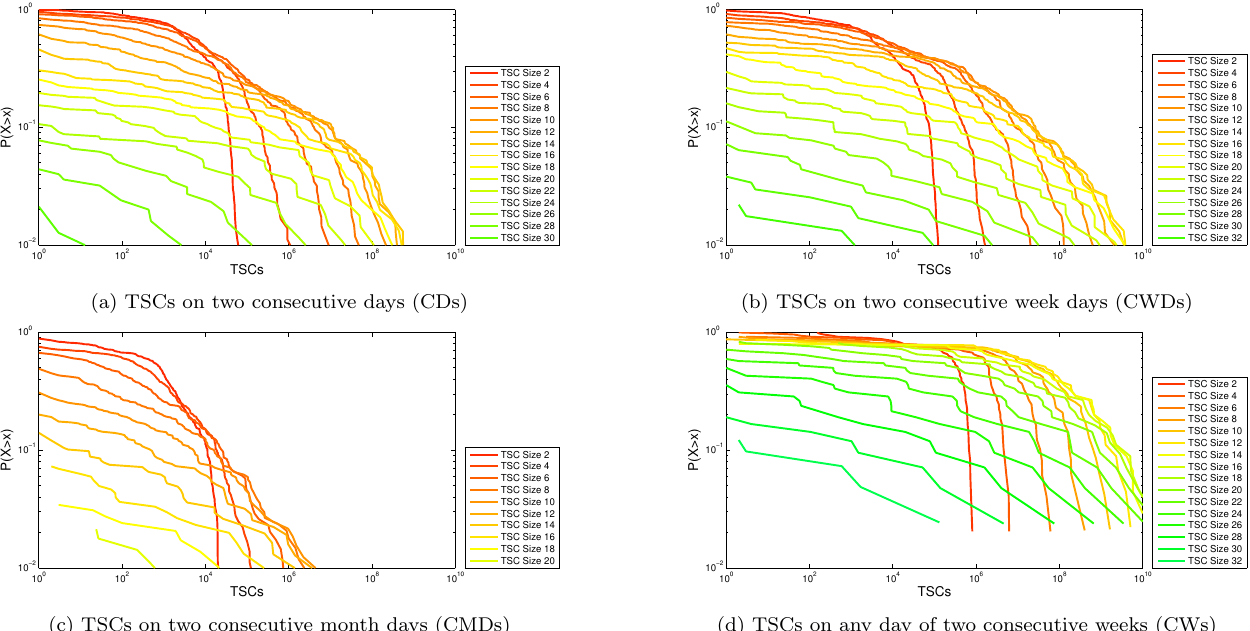
Figure 7: Temporal patterns for two consecutive periods